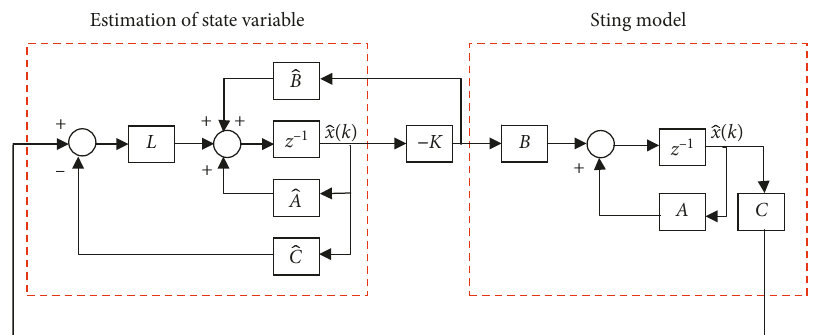
Figure 5: Diagram of a LQR